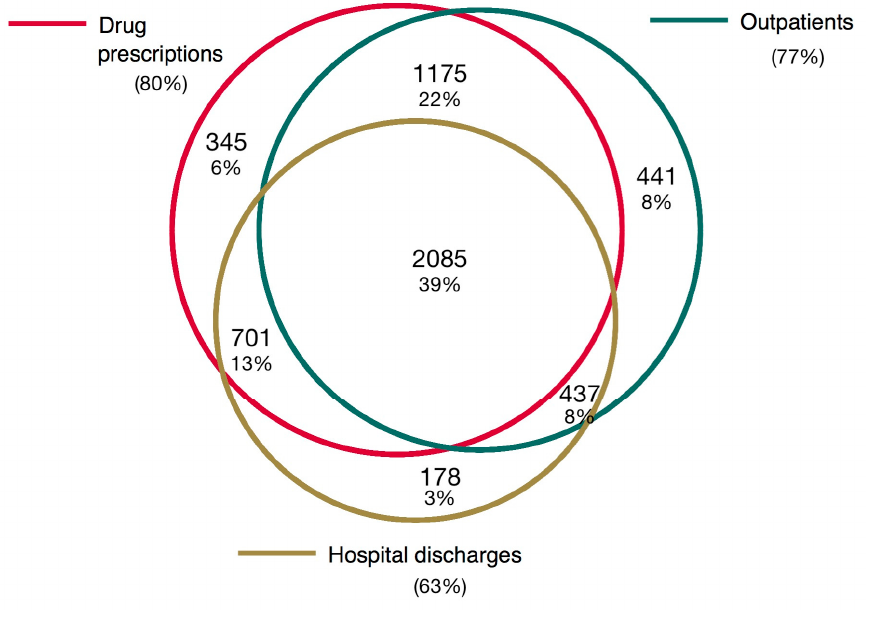
Figure 1. Venn diagram.